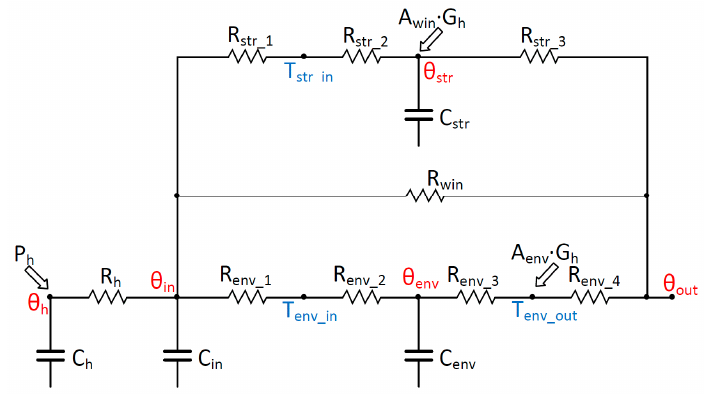
Figure 3. RC model for parameter recognition.